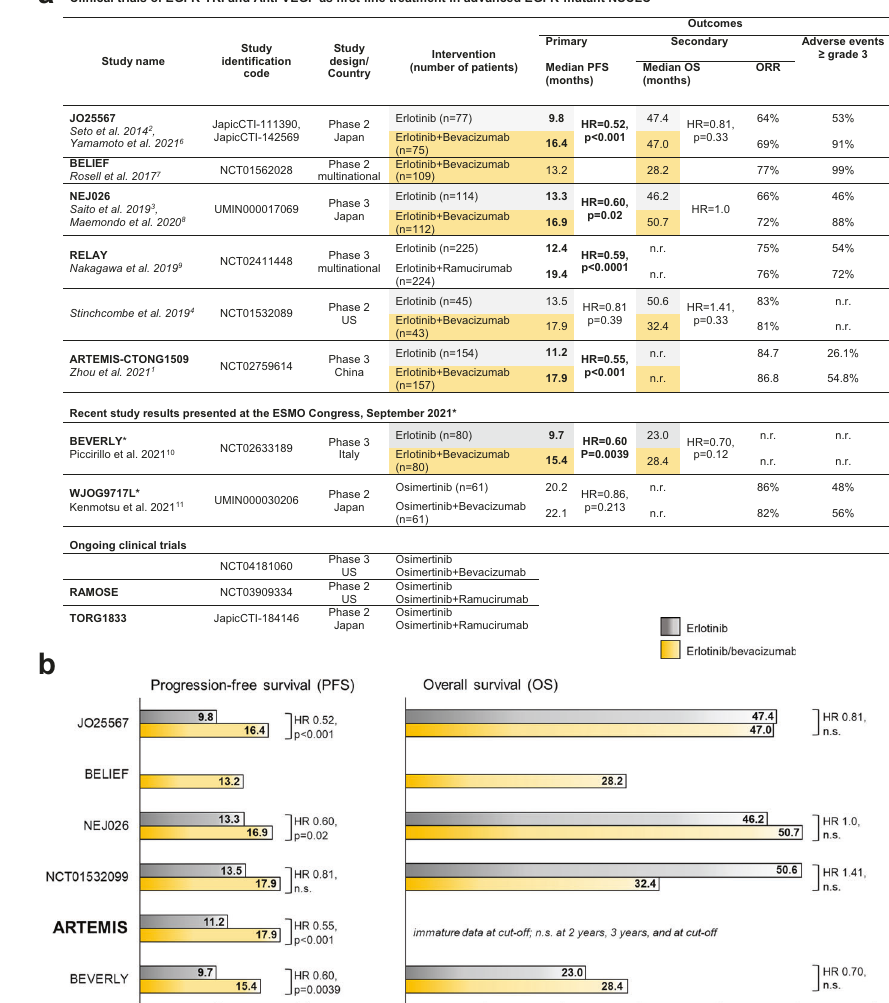
baseline might pro fi t even more from osimertinib plus VEGF inhibitors. The corresponding subgroup analyses of ongoing trials are awaited with interest. The ARTEMIS trial con fi rms previous evidence that the longs PFS in advanced EGFR-mutant NSCLC. However, caution in data interpretation and clinical implementation is advisable because the clinical bene fi t in comparison to osimertinib is unclear and an impact on overall survival and other patient- relevant endpoints has not been shown thus far.